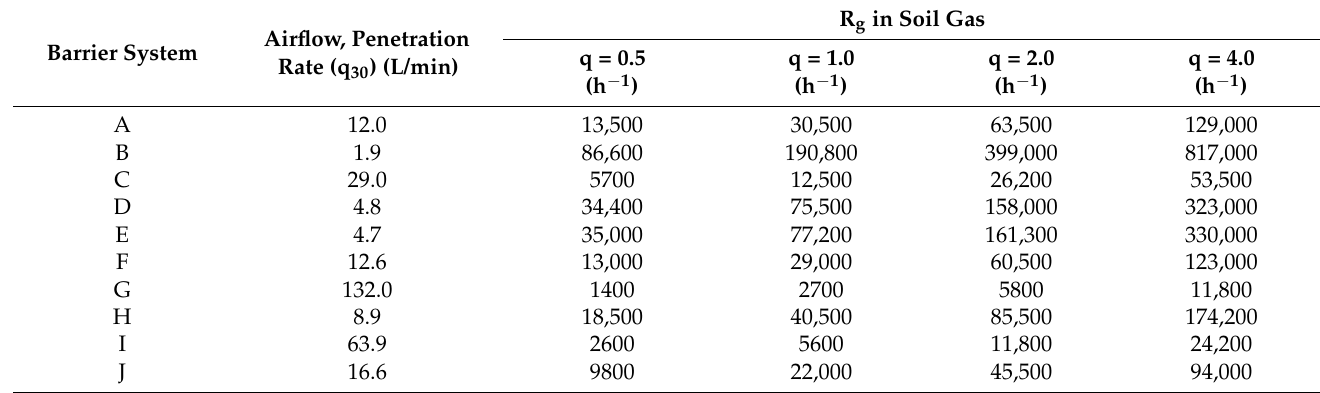
Table 4. Maximum soil gas penetration to reach an indoor-air radon concentration of 100 Bq/m 3 for System A to J barriers. The air-change rate was 0.5, 1.0, 2.0 and 4.0 h − 1 , and the initial radon contribution from indoor materials (R im ) was 40 Bq/m 3 . The airflow penetration rate (q 30 ) defines how well a barrier prevents soil gas